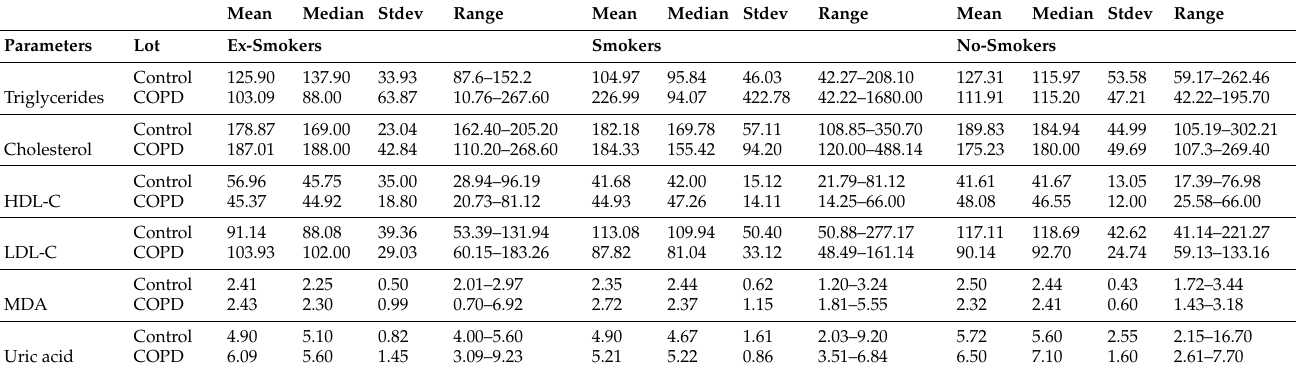
Table 6. Biochemical characteristics of the smokers/non-smokers/former smokers diagnosed with